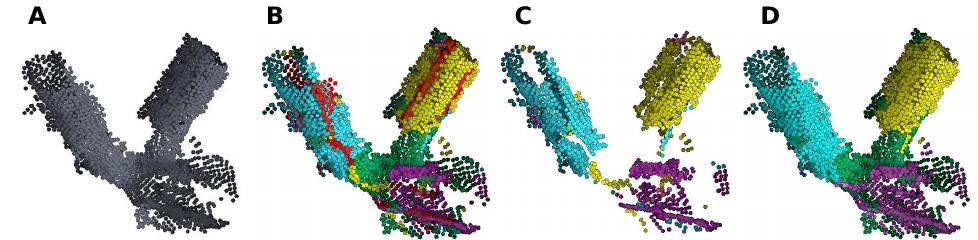
Figure 4. Clustering of ambiguous points. ( A ) Initial fork points. ( B ) Results after initial clustering. Cyan, yellow, purple: non-ambiguous points (i.e., points assigned to a single cylinder axis). Red: ambiguous points. Green: noise (i.e., points not assigned to any ring). ( C ) Non-ambiguous points only. ( D ) Final clustering after resolving the assignment of ambiguous points to a single axis/branch. The cylinder accuracy is